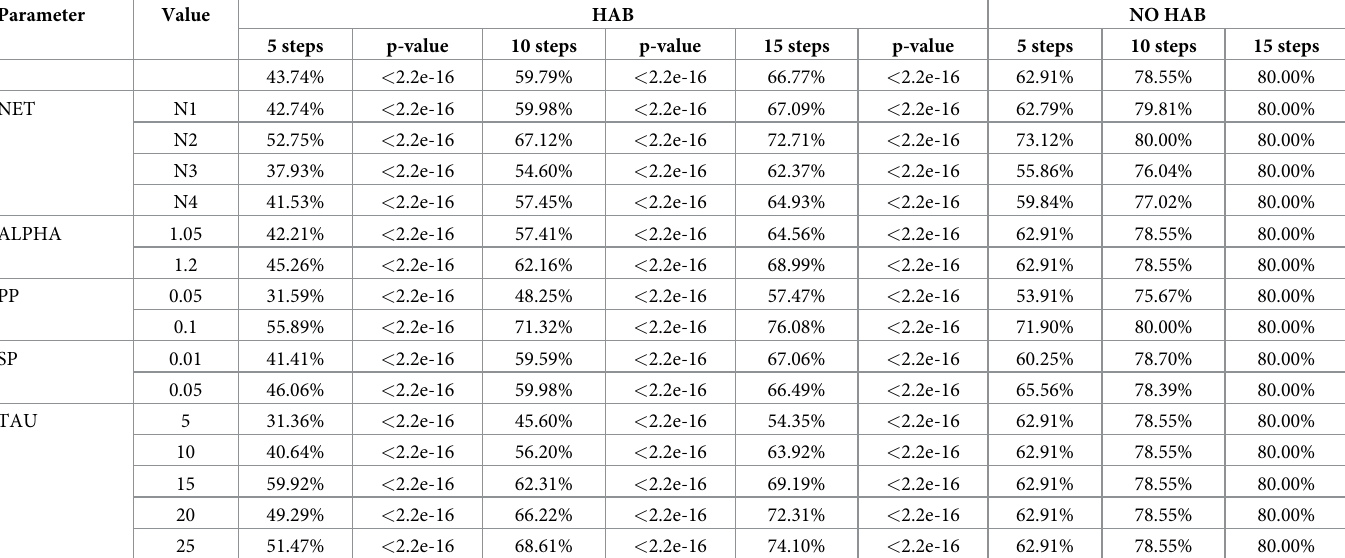
Table 3. Coverage for spreading processes with and without habituation.